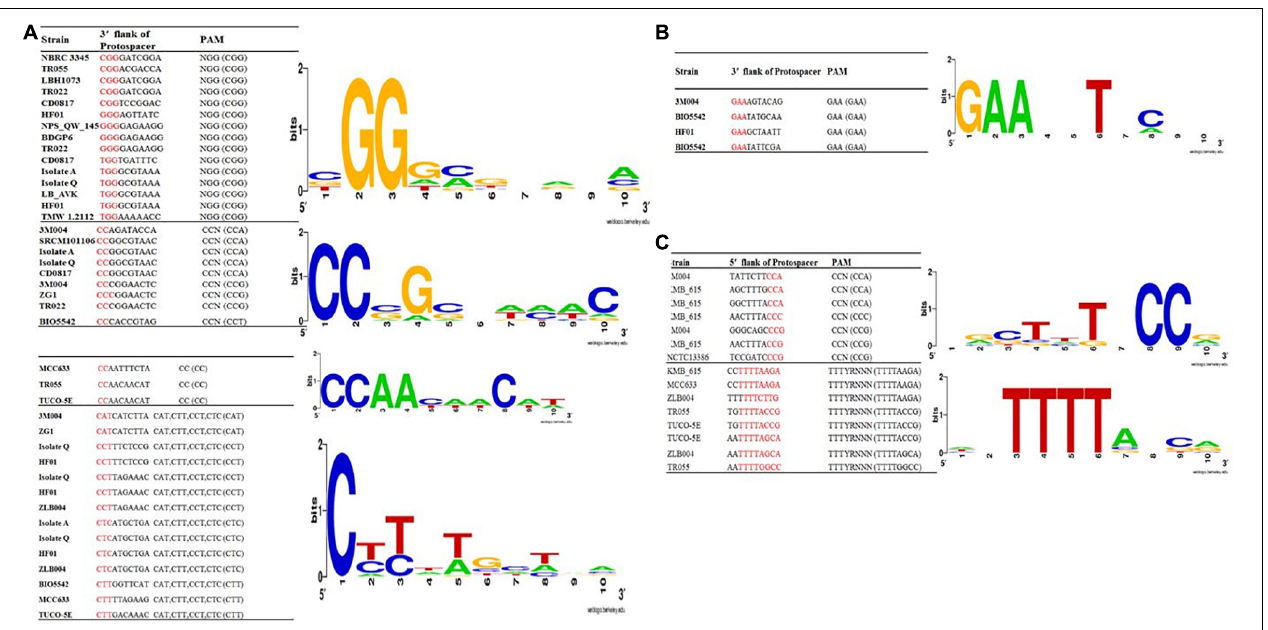
FIGURE 4 | Predicted PAMs motifs in L. brevis strain for strains which harbored the subtype II (A) , II-C (B) , and I-E (C) . The height of each letter represents the conservation of that nucleotide at each position. PAM motifs were extracted from the 10 nt flank at the 3 (cid:48) end for subtypes II-A (A) and subtypes II-C (B) and from the 10 nt flank on the 5 (cid:48) end for subtype I-E (C) of the predicted protospacers. Red color highlighted nucleotides in the given sequences are the consensus sequence of predicted PAM motifs in each strains.